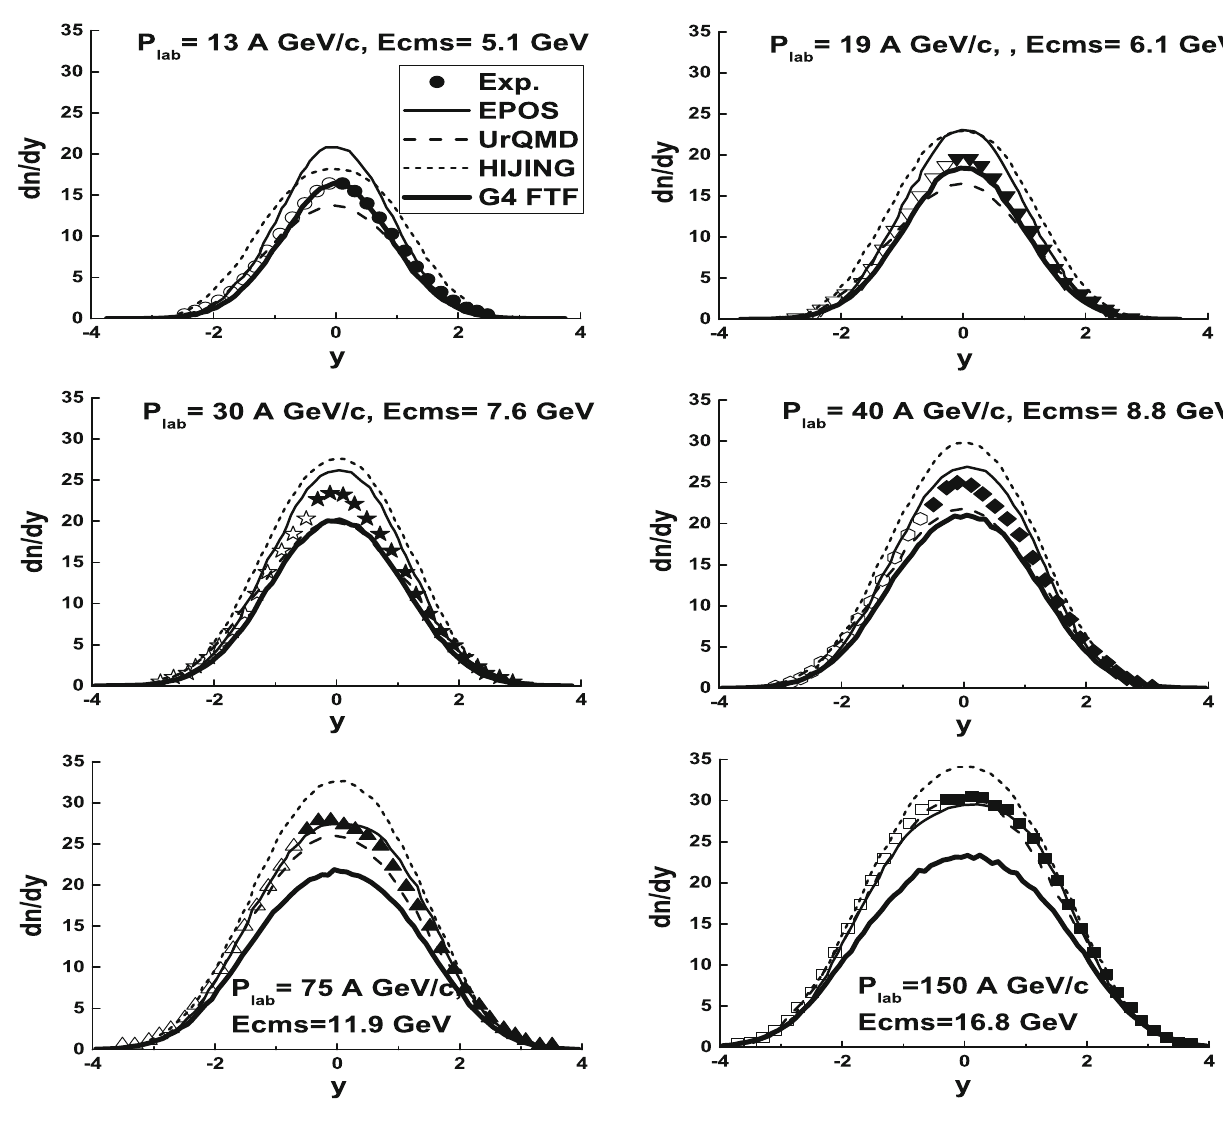
Fig. 1 Rapidity distributions, d n /d y , of π − mesons for six beam momenta in 40 Ar + 45 Sc interactions. The black points are the data measured by the NA61/SHINE collaboration for 0–5% centralities. The open points are the values extrapolated by the collaboration into an unmeasured region. All experimental uncertainties are smaller than the